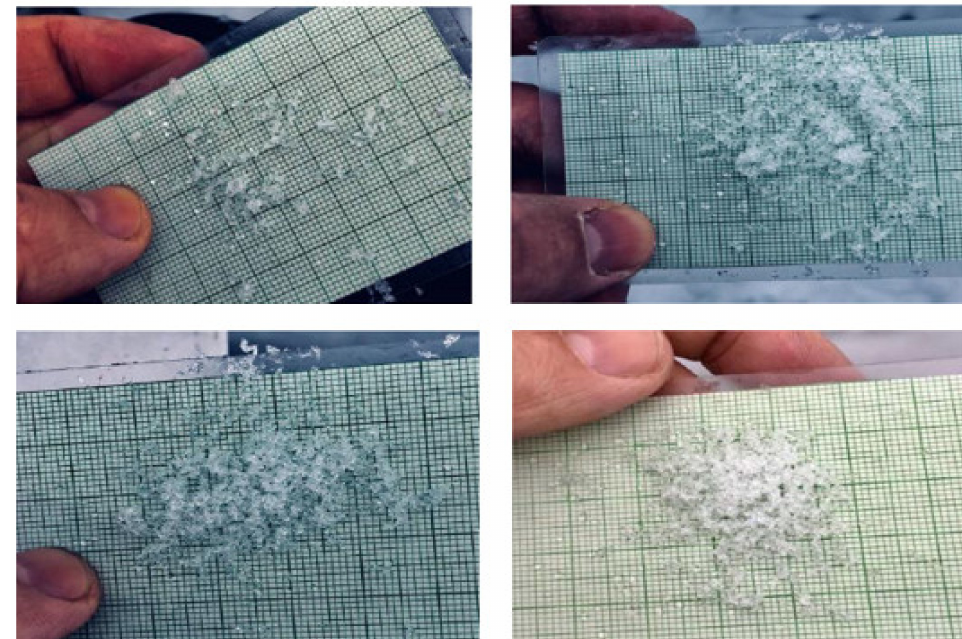
Figure 15. Snow grains from the weakly metamorphosed class.